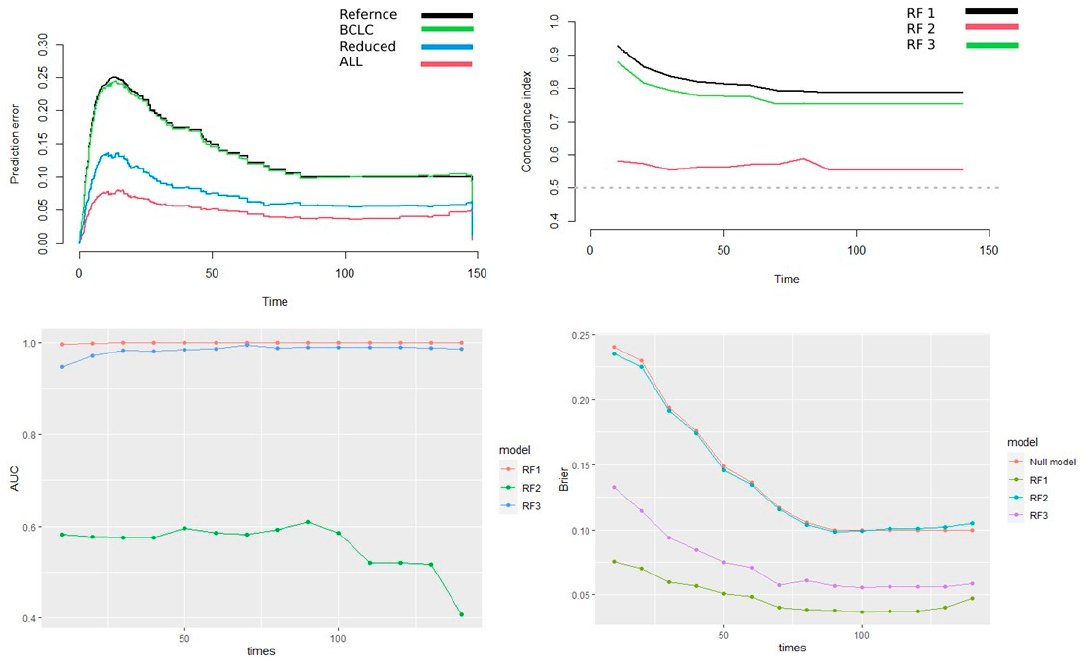
Figure 5. Top, left: Prediction error of the 3 models included in the analysis (ALL: Combined model, BCLC: model only incorporating BCLC, reduced: Model only including radiomics features). Top right: Concordance index of the 3 models (RF1: Combined model, RF2: BCLC, RF3: model using only radiomics). Bottom, left: Area under the curve during time of the 3 models (RF1: Combined model, RF2: BCLC, RF3: model using only radiomics). Bottom, right: Brier score of the models over time (RF1: Combined model, RF2: BCLC, RF: model using only radiomics).